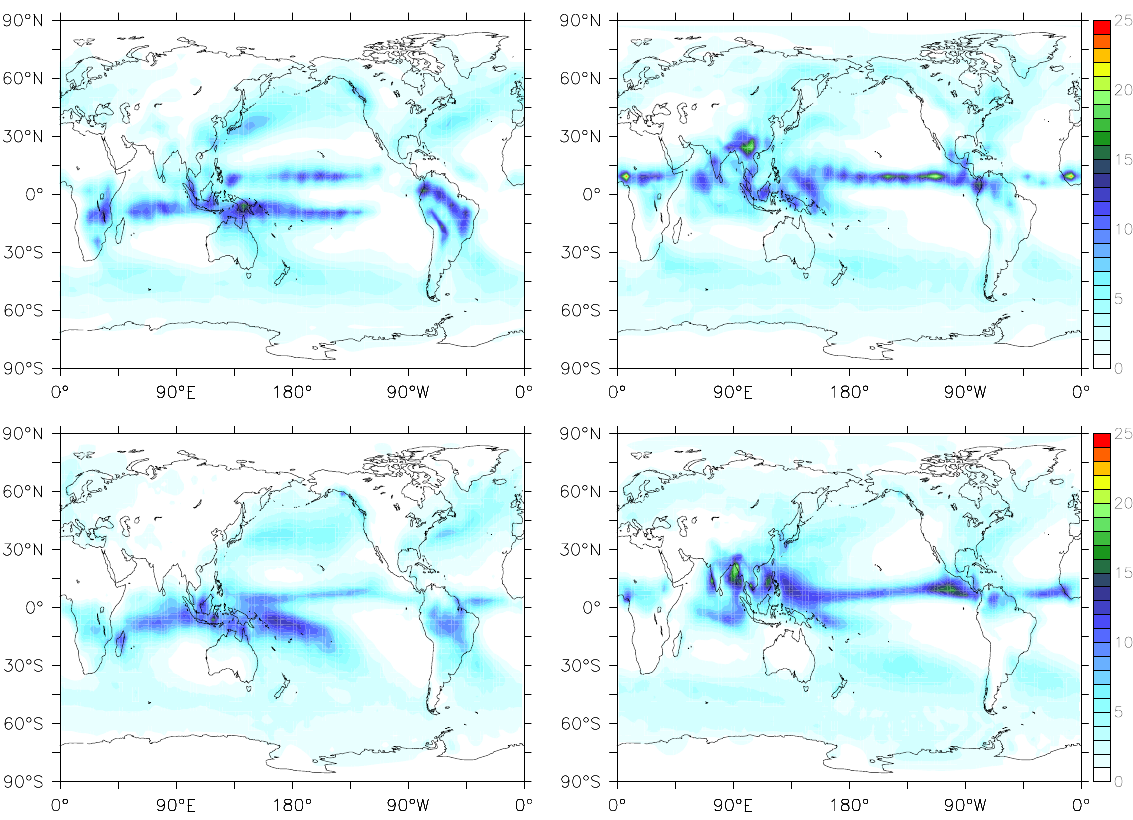
Fig. 7. The total precipitation in mmday − 1 in DJF (left) and JJA (right) for the mean of the SPEEDO ensemble (top) and from Xie and Arkin (1996), (bottom).